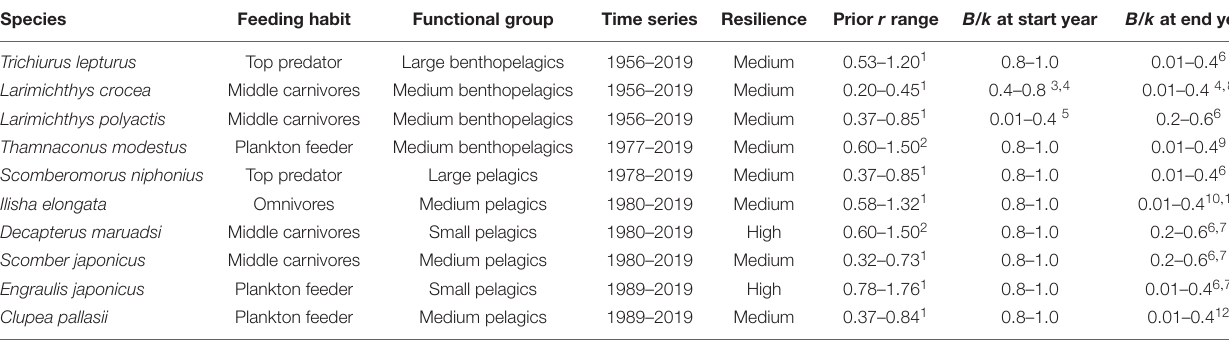
TABLE 1 | The prior range for r and B / k and other information of the investigated stocks in China. Species Feeding